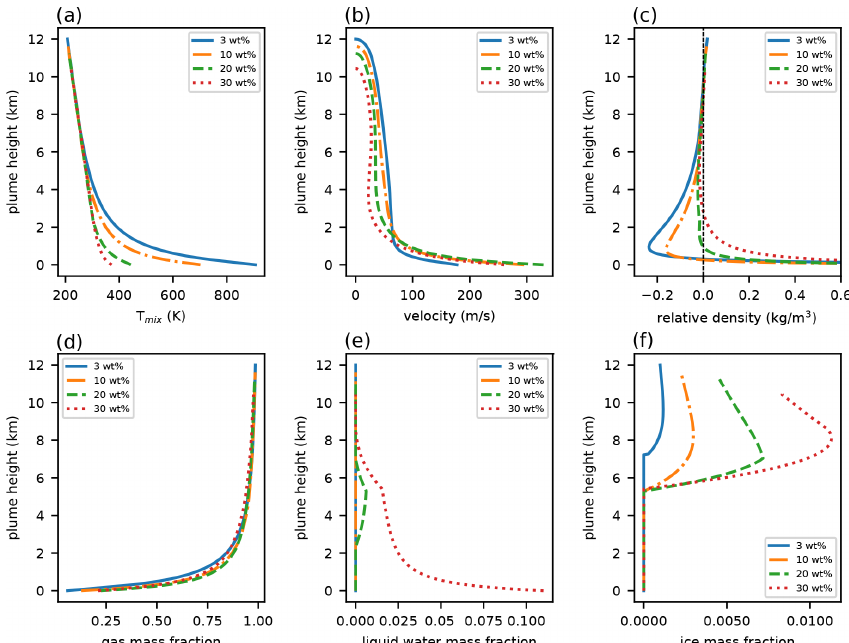
Figure C2. Variation with column height of mixture temperature (a) , velocity (b) , relative density (c) , gas mass fraction (d) , liquid mass fraction (e) , and ice mass fraction (f) . As done in Koyaguchi and Woods (1996), each curve accounts for a different amount of external water added to the magmatic mixture: 3, 10, 20, and 30wt%. The dry case is set for a vent radius of 50m and an exit velocity of 100ms − 1 , resulting in a mass flow rate of 5.7 × 10 6 kgs − 1 . The wet cases are obtained by keeping constant vent radius and mass flow rate, while varying exit velocity. Magma is assumed to contain a 0.03wt fraction of volatiles (only water vapor) and to have an initial temperature of 1000K.